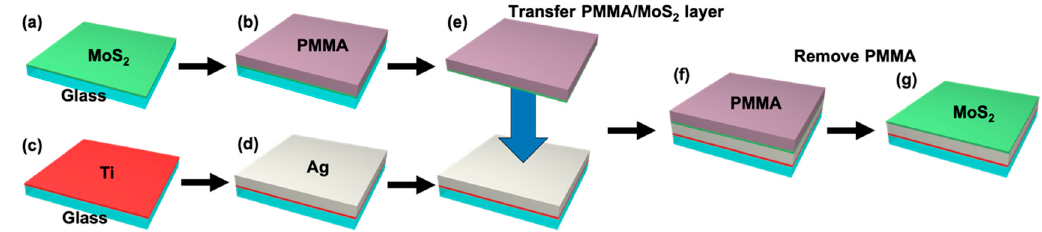
Figure 1. Schematic of fabrication processes of the Ag / MoS 2 SPR sensor substrate. ( a ) MoS 2 deposition using CVD, ( b ) PMMA spin-coating, ( c ) separation of PMMA / MoS 2 from Sapphire glass using KOH, ( d ) Ti / Ag deposition using e-beam evaporation, ( e ) PMMA / MoS 2 transferring to Ti / Ag substrate, ( f ) PMMA removal using acetone.